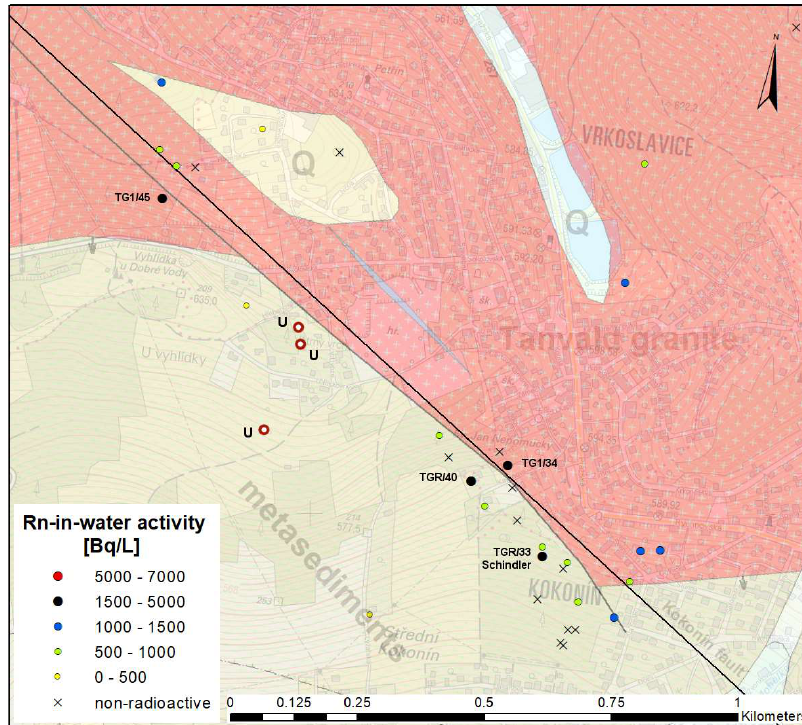
Figure 15. The Kokonín cluster with a position of radioactive water sources and outcrops of uranium mineralization. Modified from [30].